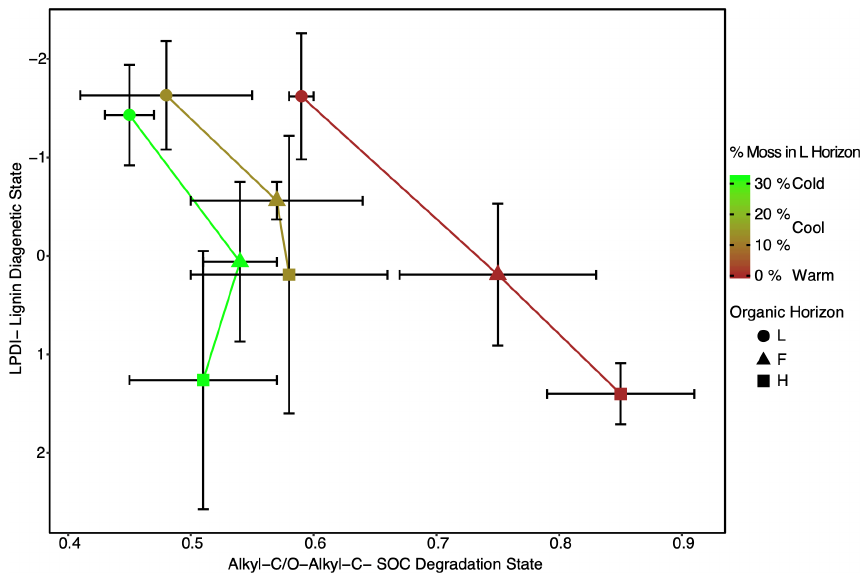
Figure 5. Lignin diagenetic state as observed through the lignin phenol diagenetic index (LPDI) is decoupled from the SOC diagenetic state as assessed through the ratio of alkyl-C to O-alkyl-C (alkyl-C / O-alkyl-C) across the climate region. Symbols signify the different horizons within the organic layer (L, F, and H). This discrepancy appears to be related to the percentage of identifiable moss detritus in the L horizons (depicted with color scaling). Values are given as the site average in each region with error bars representing the standard deviation ( n = 3). The ratios presented in this figure are